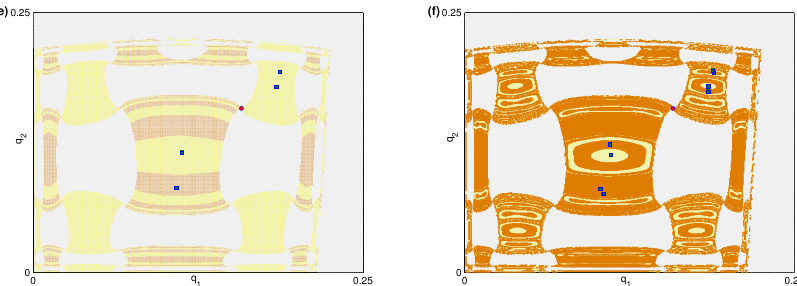
Figure 4. ( a ) Neimark-Sacker bifurcation on varying k . ( b ) Spiral and closed invariant curves at different values of k . ( c ) The phase plane of a chaotic attractor at k = 7.23. ( d ) The basin of attraction of period-2 cycle at k = 7.43. ( e ) The basin of attraction of period-4 cycle at k = 7.66. ( f ) The basin of attraction of period-8 cycle at k = 7.77.